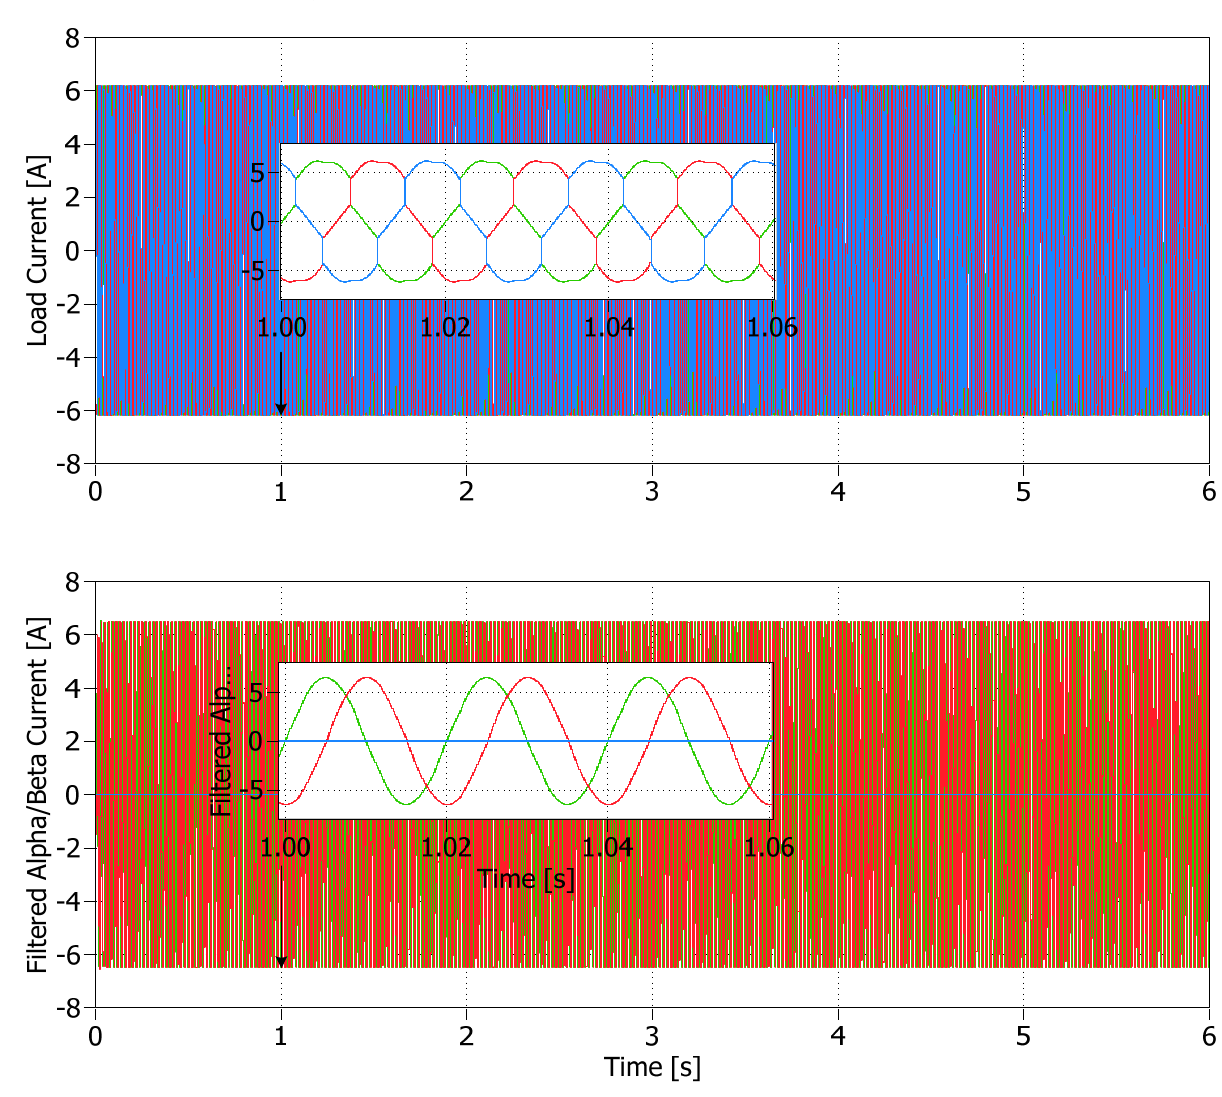
Figure 7. Load current before and after the CVF filter in alpha/beta. It is noticeable that the current is perfectly sinusoidal and does not suffer from abnor- malities thanks to the CVF filter, which smoothed the load current. Figure 8 shows the performance of the CVF compared to the PI&PLL control. The AP with the proposed CVF is more robust, stable, and optimal compared to the PI&PLL control. From [0; 0.3] s, the CVF ensures the robustness and stability during the synchronization between the PV and UGS. The PI&PLL control presents higher active and reactive power loss pulses during synchronization. However, the CVF ensures the elimination of the RP fluctuations during synchronization (Q(VAR) =